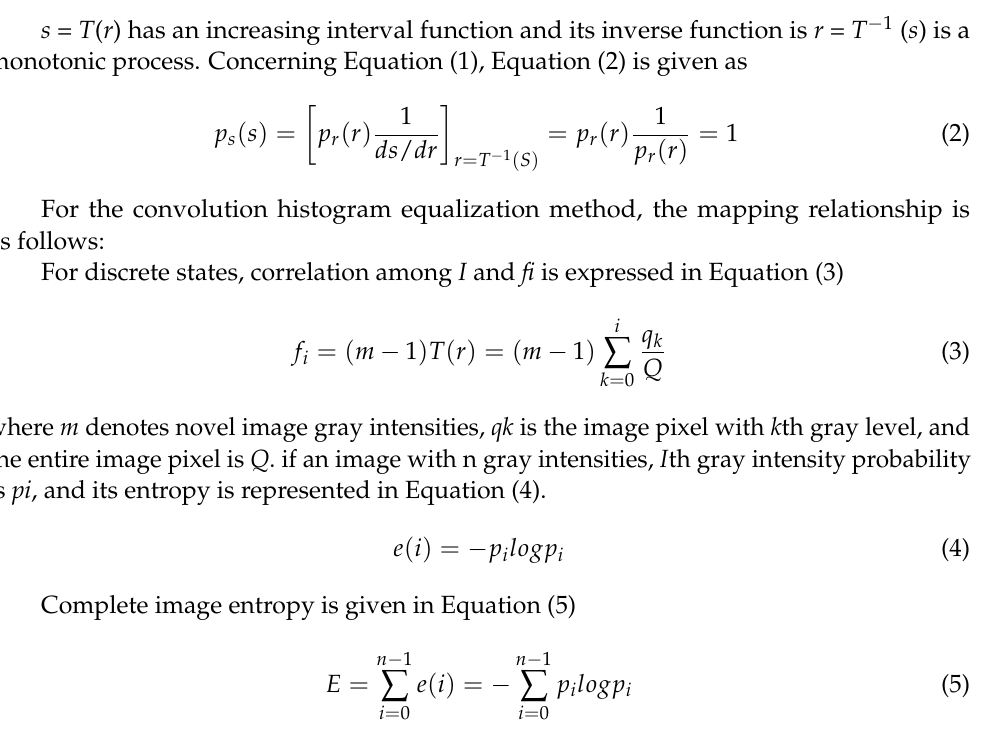
Figure 1. Proposed architecture of